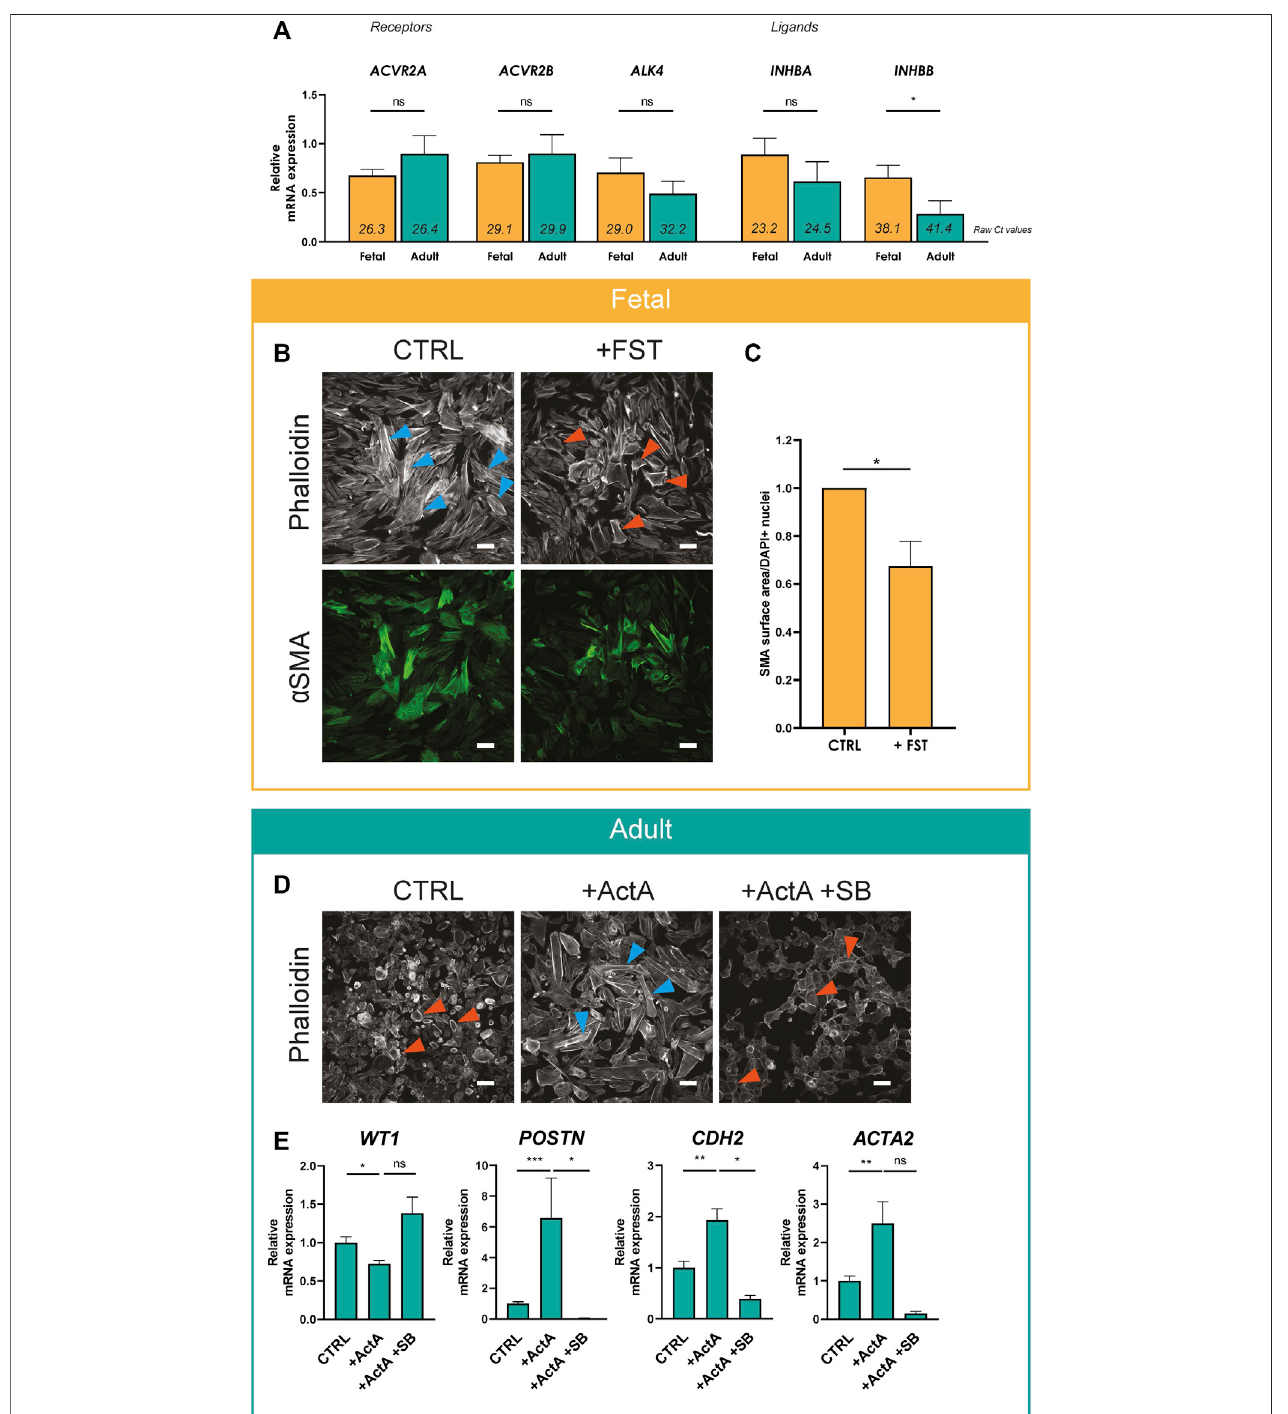
FIGURE2| ActivinAsignalingregulatesepiMT (A) mRNAexpressionlevelsforActivinreceptortype2A( ACVR2A ),Activinreceptortype2B( ACVR2B ),Activinreceptortype 1B( ALK4 ),InhibinsubunitbetaA( INHBA )andInhibinsubunitbetaB( INHBB )determinedincobblefetalandadultEPDCsculturedfor3 hafterremovalofSB( n (cid:1) 6).RawCtvalues perconditionareshowninitalics.* (cid:1) p < 0.05,ns (cid:1) notsigni fi cant(unpairedStudent ’ s t -test).Dataaredisplayedasmean+SEM. (B) Immuno fl uorescentstainingforphalloidinand α SMAinfetalEPDCsculturedfor5 daysincontrol(CTRL)orFSTcontainingmedium.Orangearrowsindicateexamplesofepithelialcobblestone-shapedcells,bluearrowsof mesenchymalspindle-shapedcells.Scalebar:100 µm. (C) Quanti fi cationof α SMApositivesurfaceareaofFSTtreatedcellsrelativetoCTRL( n (cid:1) 7).* (cid:1) p < 0.05(pairedStudent ’ s T-Test). (D) Phalloidinstainingin adultEPDCsculturedfor5 daysincontrolmedium(CTRL),mediumcontainingActivinA,orActivinAincombinationwith SB431542.Scalebar: 100 µm. (E) mRNAexpressionlevelsof WT1 , POSTN , CDH2 and ACTA2 ofadultEPDCsculturedfor5 daysinthepresenceofActA( n (cid:1) 7)orActA+SB( n (cid:1) 3),relativetoCTRL.* (cid:1) p < 0.05, ** (cid:1) p < 0.01, ns (cid:1) not signi fi cant (mixed-effects analysis, Sidak ’ s multiple comparisons test).